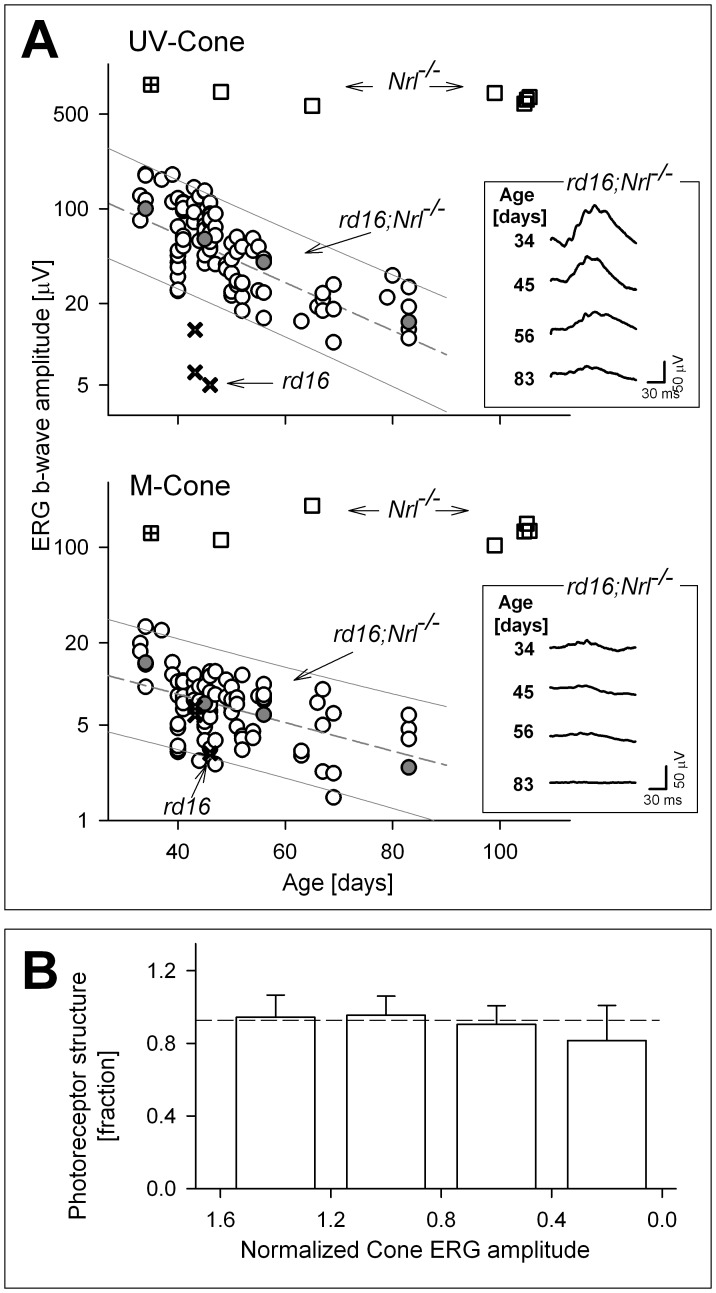
Structure and function in the rd16;Nrl−/− mouse retina.(A) ERG b-wave amplitudes of responses to UV- and M-cone stimuli as a function of age in rd16;Nrl−/− mice from P34 to P83 (n = 95) with comparisons to data from previously recorded signals in Nrl−/− (squares [11]; square with cross [19]), and rd16 (crosses [7]) mice. Upper: Cone b-wave responses to ultraviolet (UV, 360 nm peak) stimuli in the rd16;Nrl−/− mice are severely reduced compared with those of Nrl−/− mice at comparable ages. Amplitudes in rd16 mice are low compared to the other mice. It is also notable that ERGs of the Nrl−/− mice remain relatively stable throughout this age range, while ERGs of the rd16; Nrl−/− and rd16 mice decline in amplitude with age. Lower: Responses to green (510 nm) stimuli are substantially lower in amplitude than those from UV-cone stimuli. Again, Nrl−/− mice have the largest amplitudes and do not decline with increasing age within this time period. The rd16;Nrl−/− waveforms are lower in amplitude and there is a reduction with age. Only limited data were available for rd16 mice and these fell within the range of rd16;Nrl−/− amplitudes. Waveforms for representative rd16;Nrl−/− mice at various ages (grey-filled circles) are illustrated in the panels at right. Grey lines: linear regression fit to log-converted data (dashes) and 95% prediction intervals (solid). Squares with cross at earliest age in graphs: Nrl−/− data from Mears et al., 2001 (B) Photoreceptor structure (ONL+) as a function of the combined UV- and M-cone ERG b-wave amplitudes. ONL+ remains similar to the value at P31 (youngest age rd16;Nrl−/− we studied) across various degrees of ERG amplitude reduction. Horizontal dashed line is the reference level for the lower limit of retinal structure thickness at P31 (−2SD from the mean at this age); photoreceptor structure above this lower limit indicates no difference compared to the data of P31 (error bars, +2SD from mean).